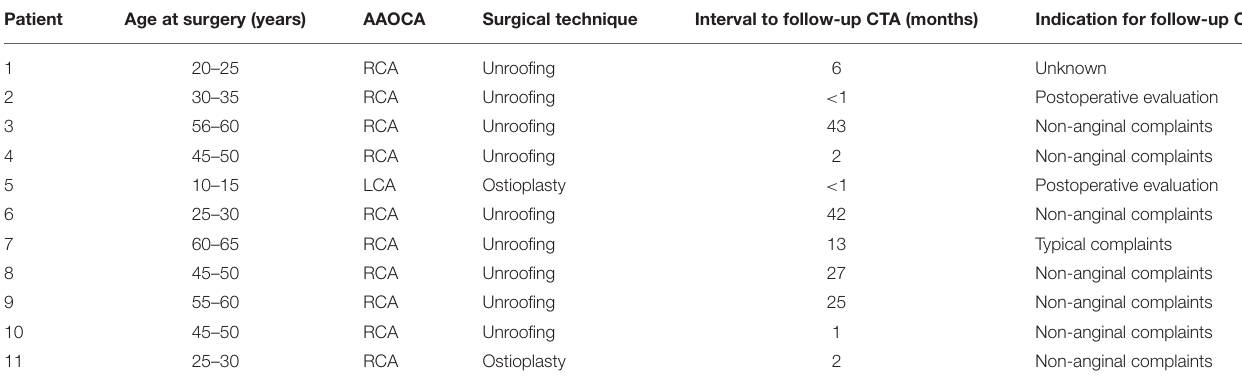
TABLE 2 | Individual patient characteristics at surgery and follow-up.